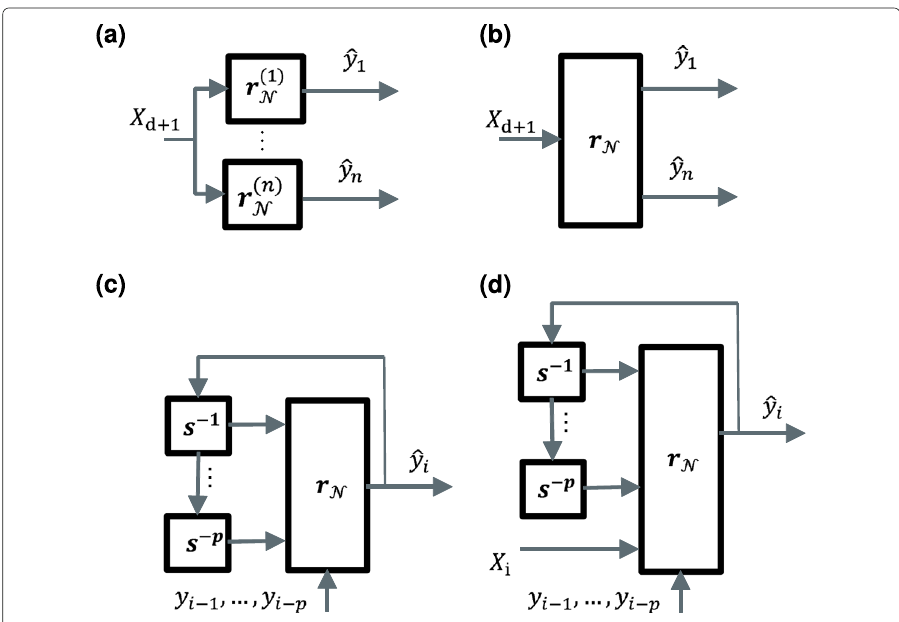
Fig. 2 Network architectures for the day-ahead prediction. a MISO-MLP model using direct strategy; b MIMO-MLP model using multi-out strategy; c NAR model and d NARX model with external input - both using recursive strategy. Further description is provided in the text